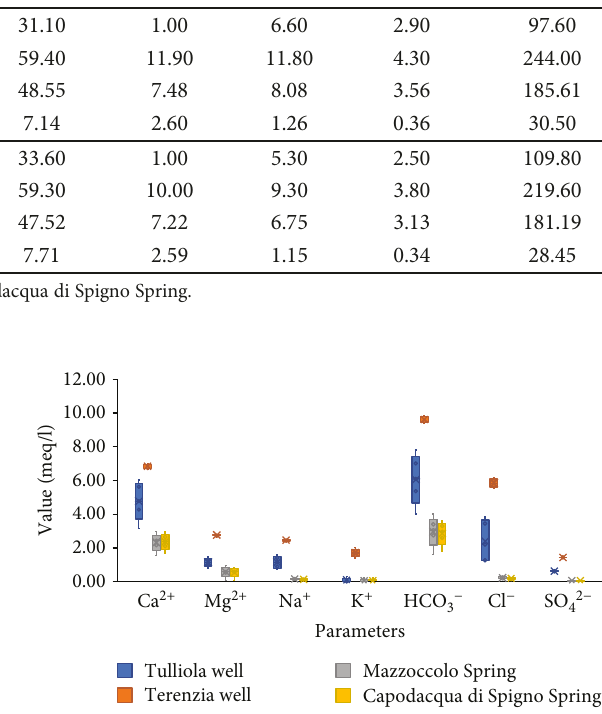
Figure 5: Boxplot of the major composition in the spring and well water